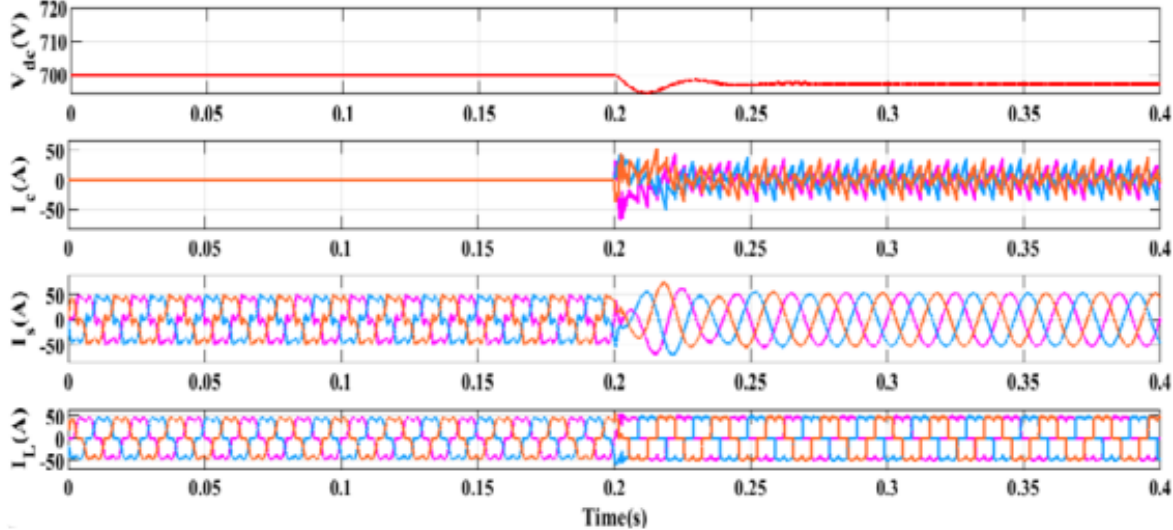
Figure 18. The behavior of Icos θ -based DSTATCOM in current source-based non-linear